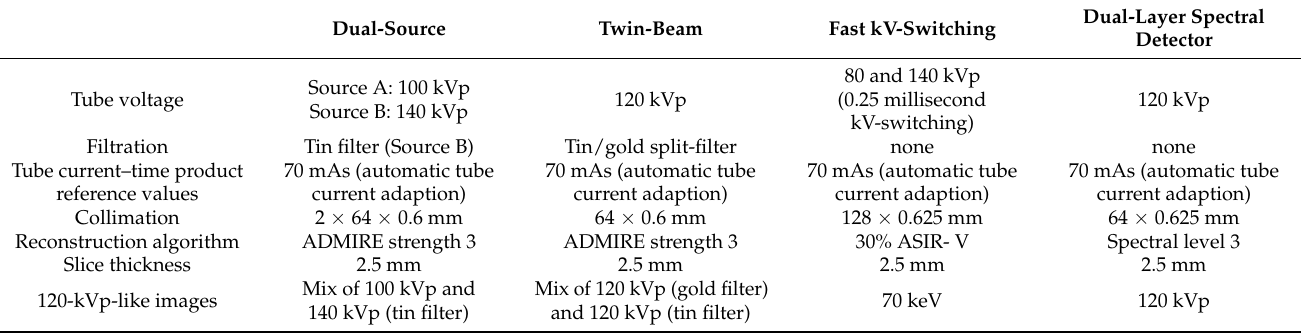
Table 1. Scan parameters of the different CT scanners. ASIR-V (adaptive statistical iterative recon- struction). ADMIRE (advanced modeled iterative